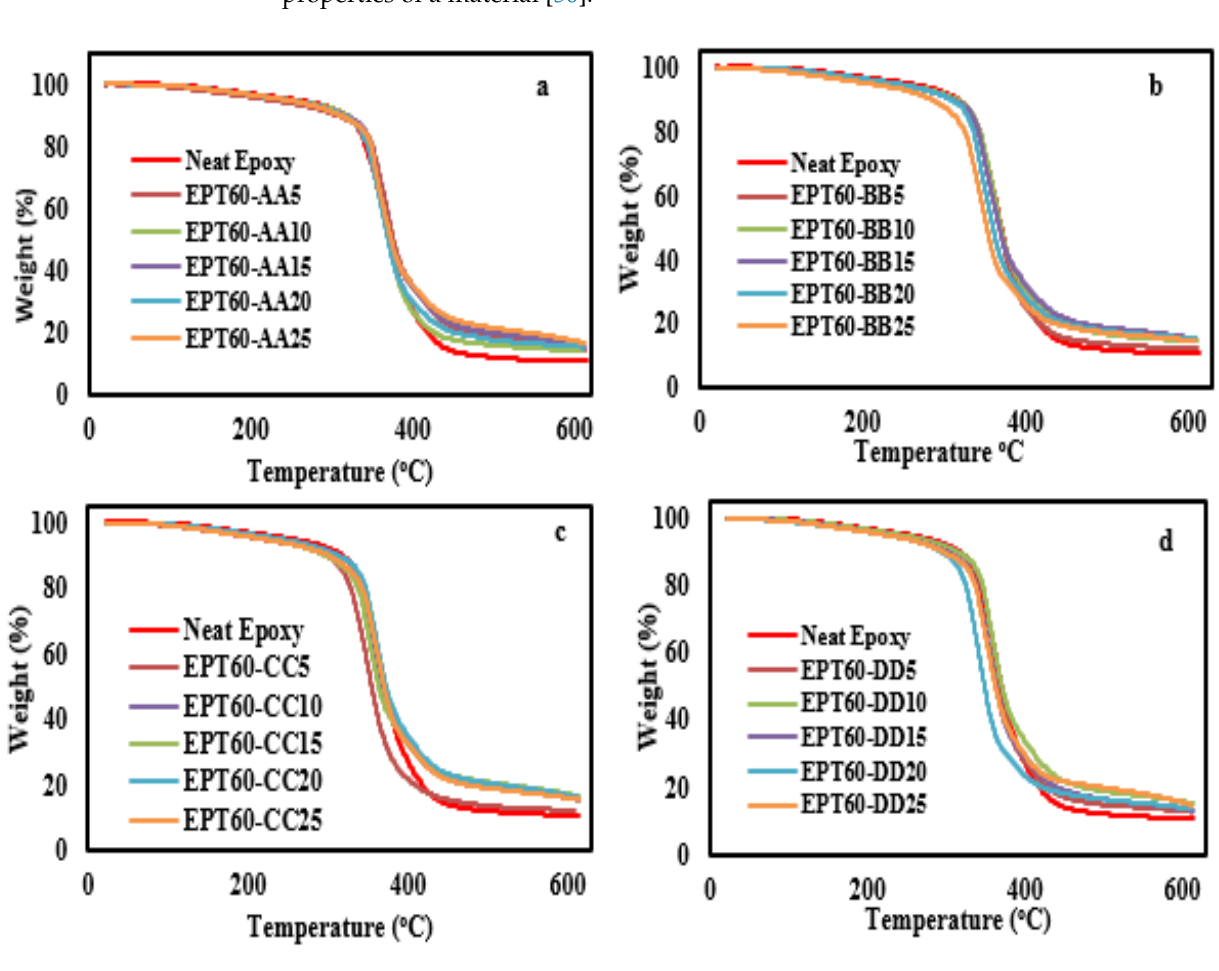
Figure 8. TGA analysis of SFC-homogenous HGM at ( a ) EPT60-AA, ( b ) EPT60-BB, ( c ) EPT60-CC, and ( d ) EPT60-DD. Showing all the volume fraction variations compared with the neat